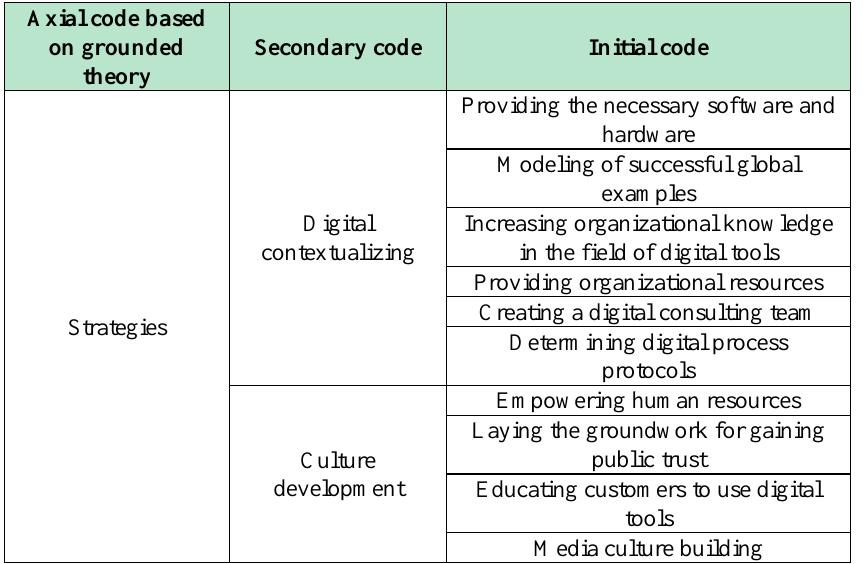
Table 2: Open coding of qualitative data (Strategies) Axial code